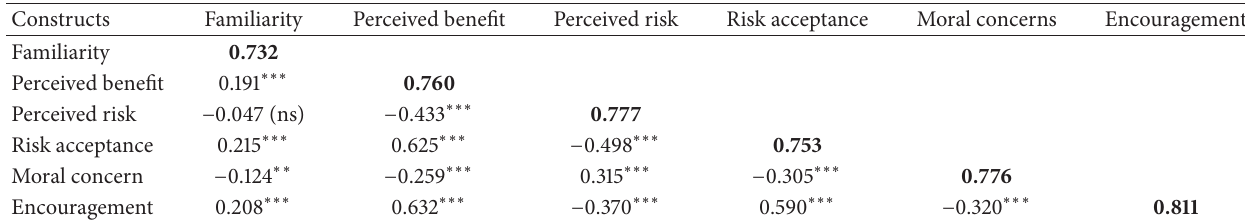
Table 3: AVE square roots and correlation matrix of the constructs.